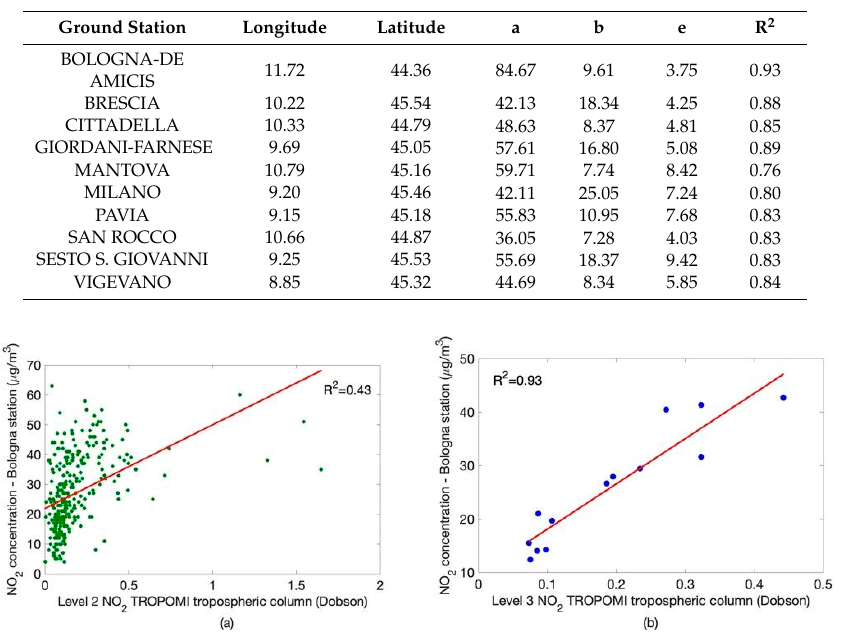
Table 1. Longitude (deg east) and latitude (deg north) of North Italy ground stations, slope (parameter a in units of (cid:2020)(cid:1859) (cid:1865) (cid:2879)(cid:2871) (cid:1830)(cid:1867)(cid:1854)(cid:1871)(cid:1867)(cid:1866) (cid:2879)(cid:2869) ) and intercept (parameter b in units of (cid:2020)(cid:1859) (cid:1865) (cid:2879)(cid:2871) of the linear regression, regression error (parameter e in (cid:2020)(cid:1859) (cid:1865) (cid:2879)(cid:2871) ) and correlation ( R 2 ).